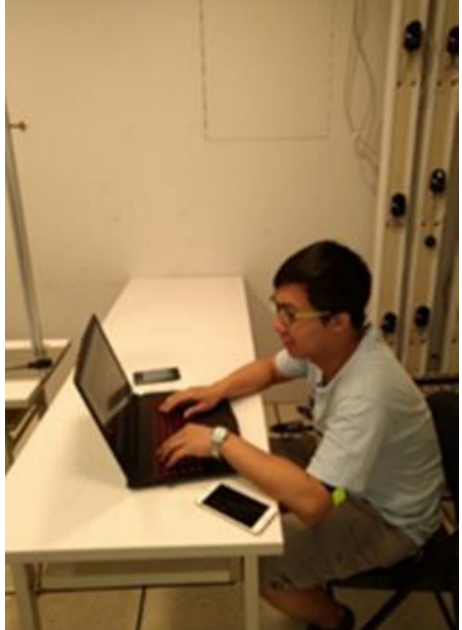
Figure 5. Actual typewriting status chart.